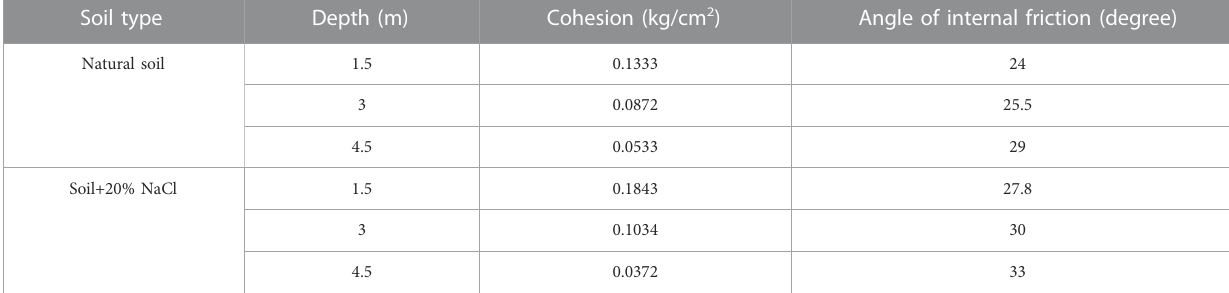
TABLE 7 Shear strength parameters for natural soils and treated soils with 20% NaCl at different depths. Soil type Depth (m) Cohesion (kg/cm 2 ) Angle of internal friction (degree) Natural soil 1.5